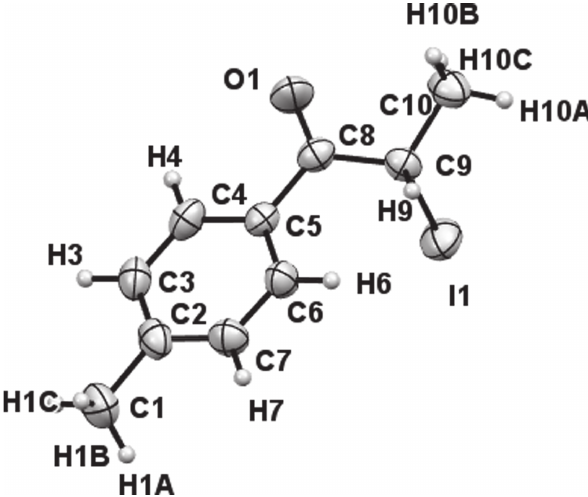
Table 1: Data collection and handling.